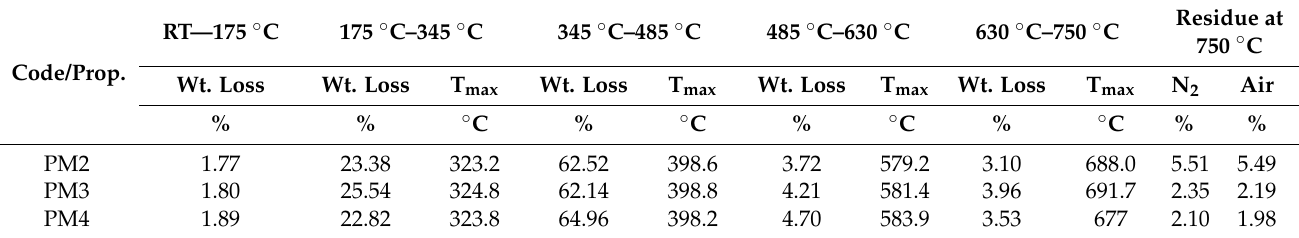
Table 10. Thermal degradation of mechanically recycled